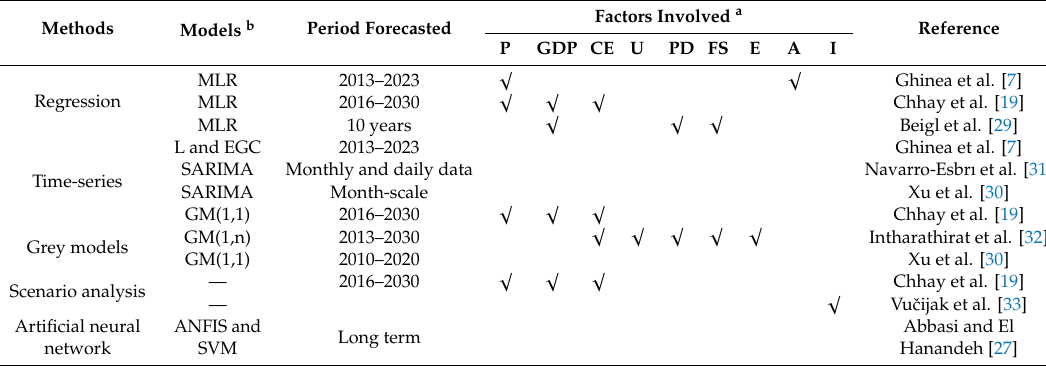
Table 2. Methods used in municipal solid waste (MSW) forecasting